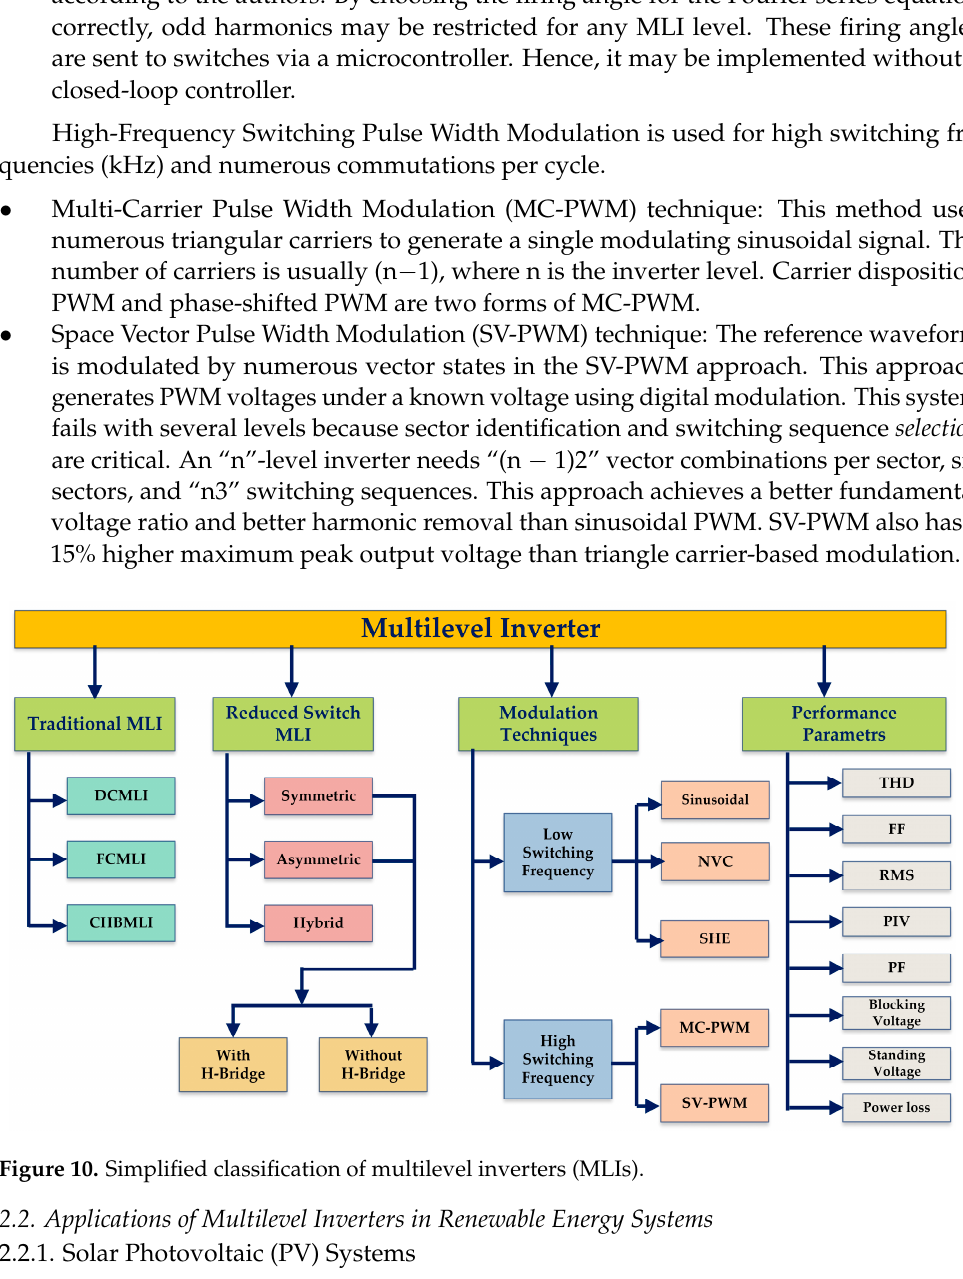
Figure 10. Simpli fi ed classi fi cation of multilevel inverters (MLIs). Figure 10. Simplified classification of multilevel inverters